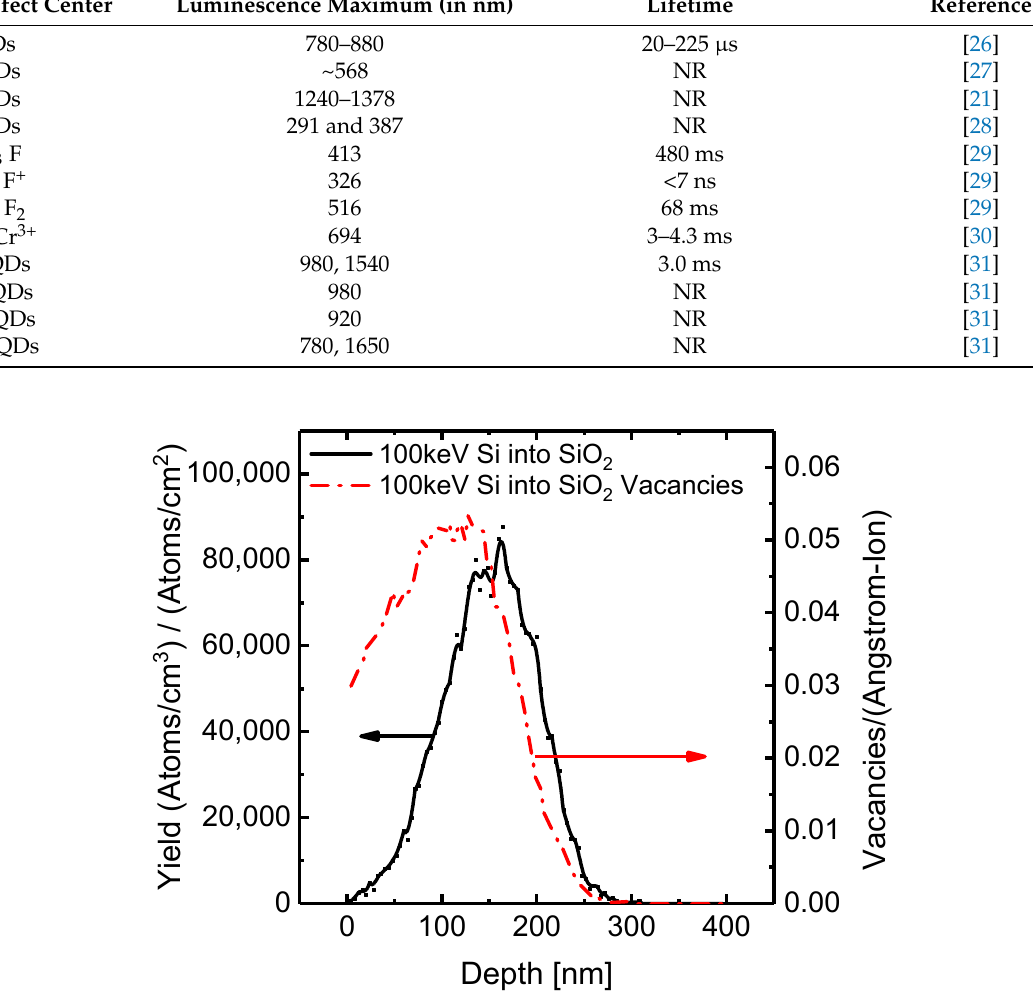
Figure 2. Implanted Si ion yield (black curve with values shown on the left Y-axis, indicated with black arrow) and vacancy profile (red dash-dotted line with values shown on the right axis, indicated by red arrow) as a function of depth in SiO 2 for 100 keV incident energy, simulated with SRIM code [23]. The Si QD diameter can be controlled by changing the Si implantation dose, as pre- sented in Figure 3. Photoluminescence (PL) measurements were performed at room tem- perature with a 325 nm laser at 17 mW, an effective power density of 0.64 W/cm 2 , and were analyzed by an Ocean Optics spectrometer. From the position of the PL maximum for the 1 × 10 17 Si/cm 2 sample at 870 nm (1.42 eV), we can estimate an average Si QD diameter of D = 2.07 nm, using bandgap energy of E g ( D ) = E g ( ∞ ) + A eV nm 2 , where E g ( ∞ ) = 1.1 eV D 2 for crystalline Si, and A =